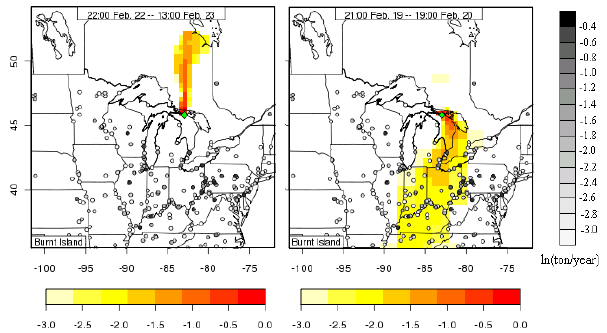
Fig. 6. Modeled footprints [log 10 (ppm/(µmole/m 2 /s))] for the se- lected Hg plume (right) and low episode (left) in 18–27 February for Burnt Island site (green diamond). Important Hg point sources are designated with circles and the greyscale shadings of the circles represent their emission strengths.